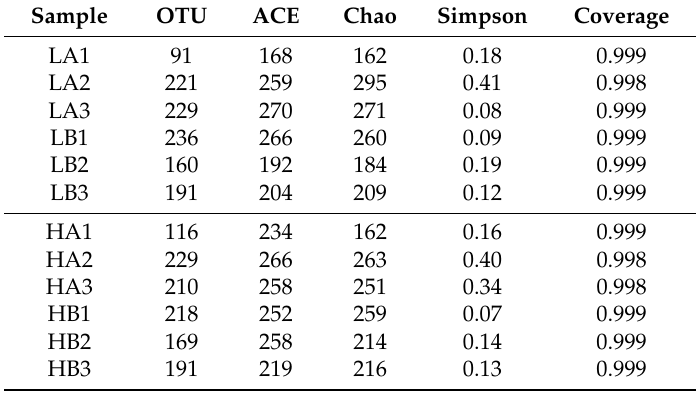
Table 3. Alpha diversity index along the filter under two organic